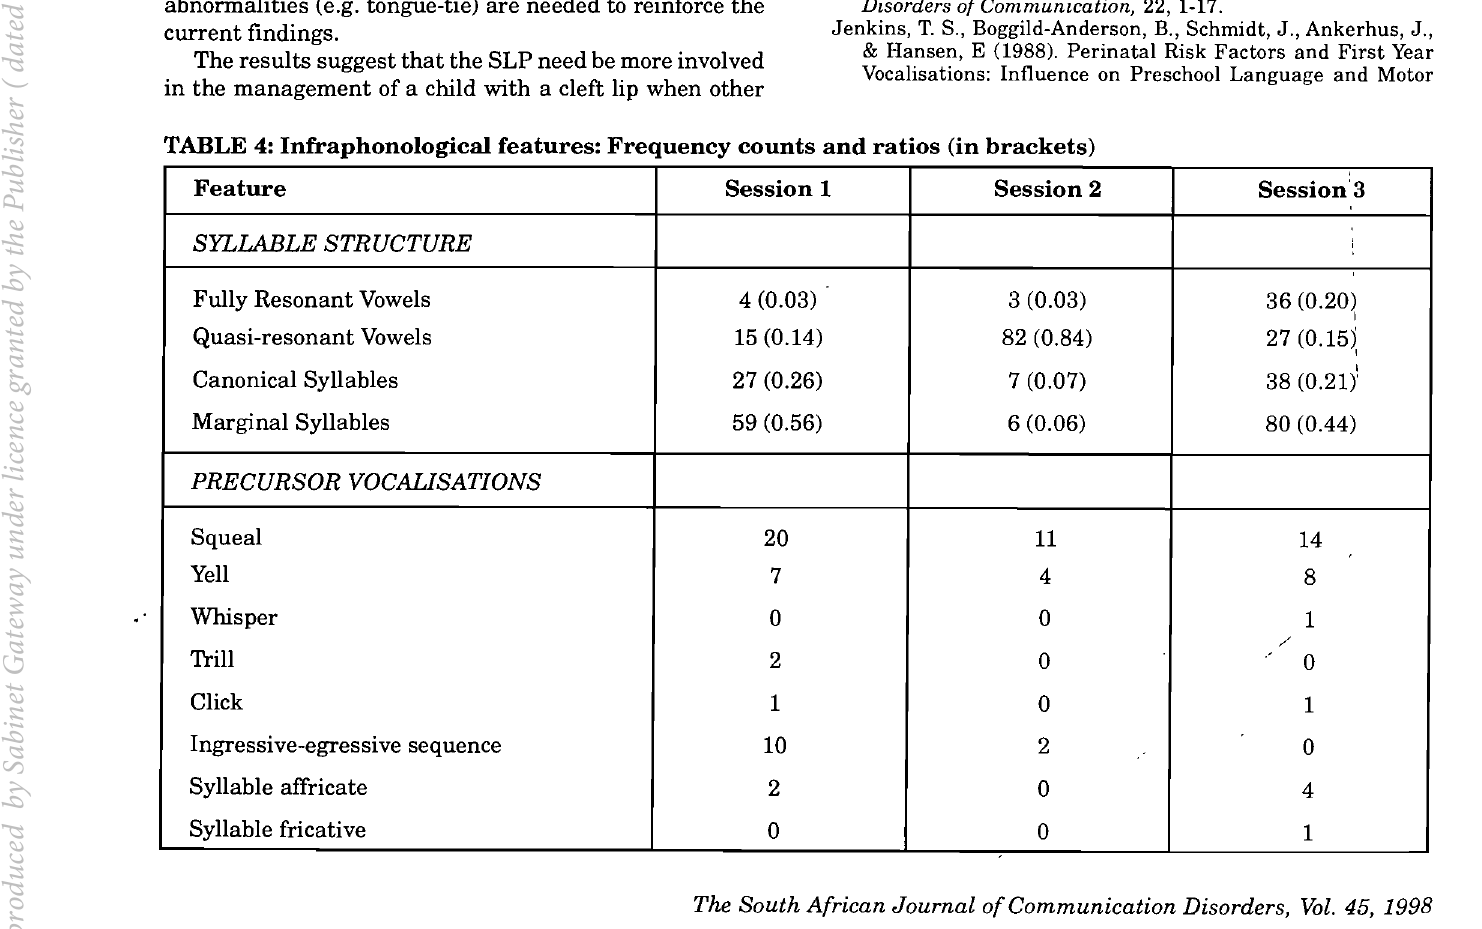
TABLE 4: Infraphonological features: Frequency counts and ratios (in brackets)